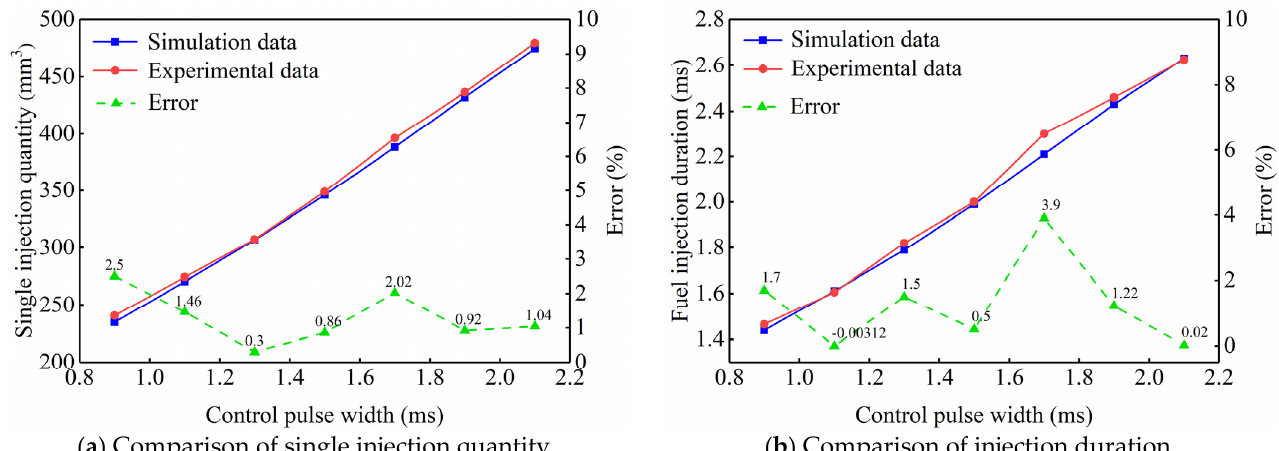
Figure 7. Comparison of 1D model and experiment.